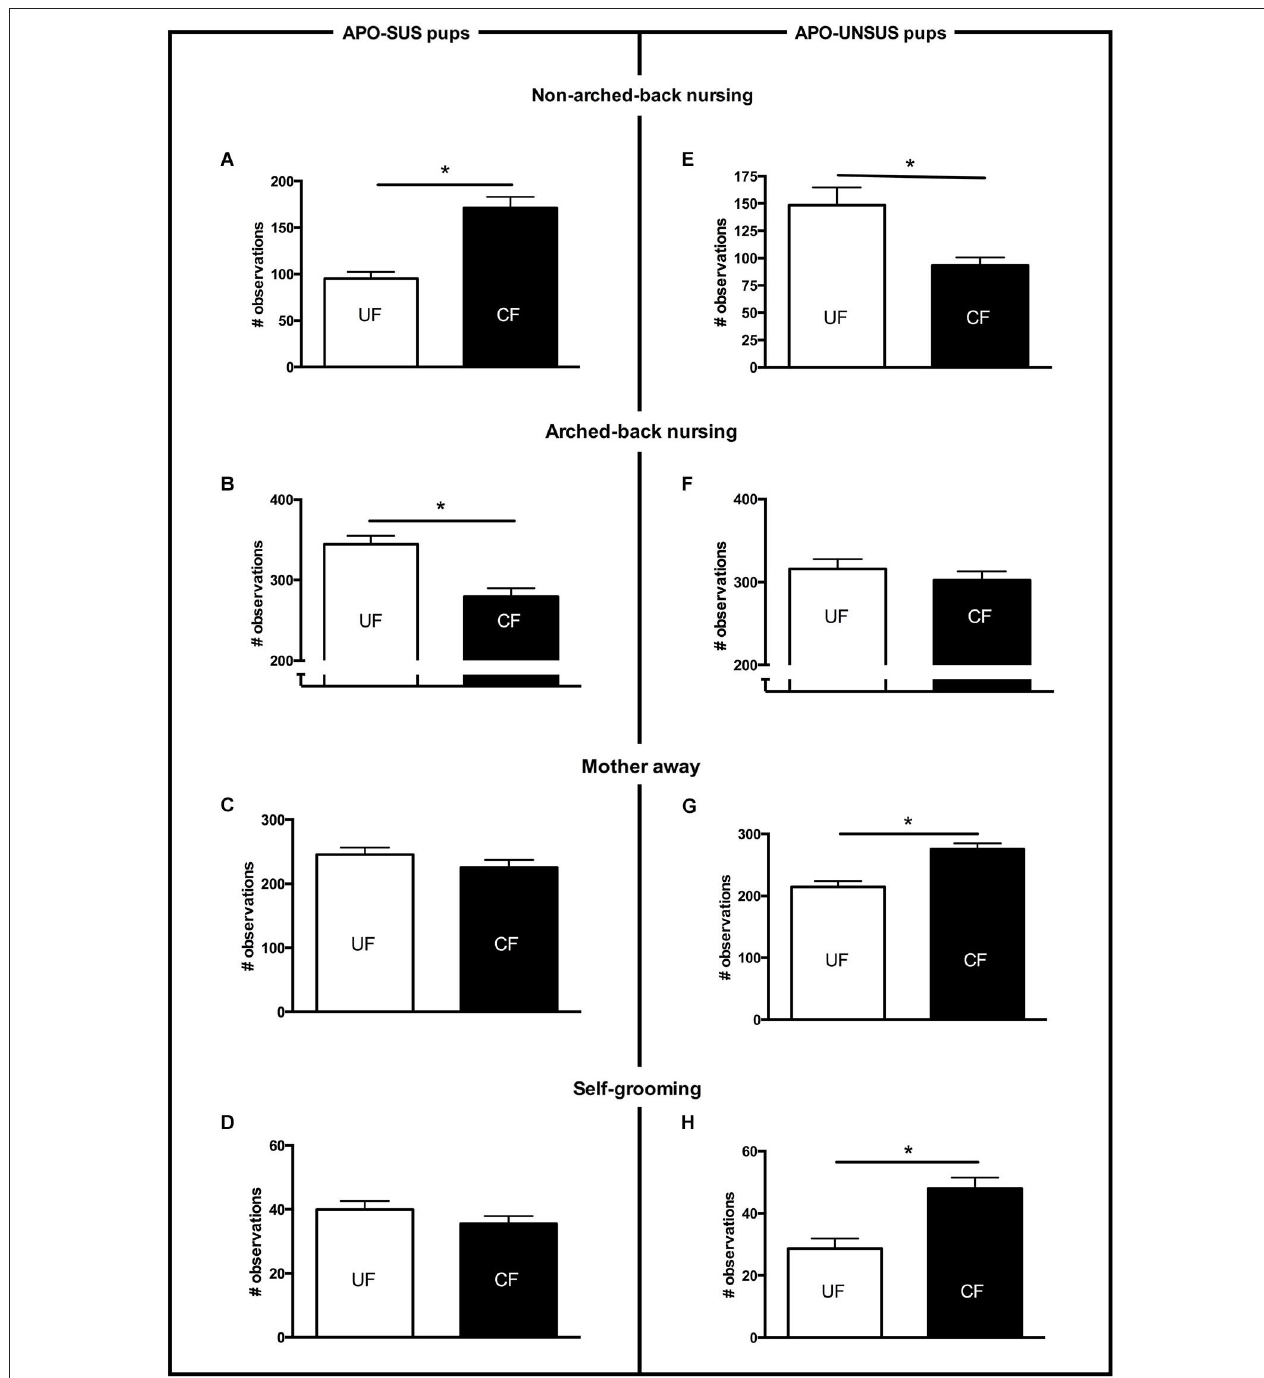
nursing; (C and G) : mother away; (D and H) : self-grooming. The total number of observations per nest was 700. * p < 0.05. Note: To avoid nest disturbance, gender-specific maternal care was not analyzed (see Section Discussion).